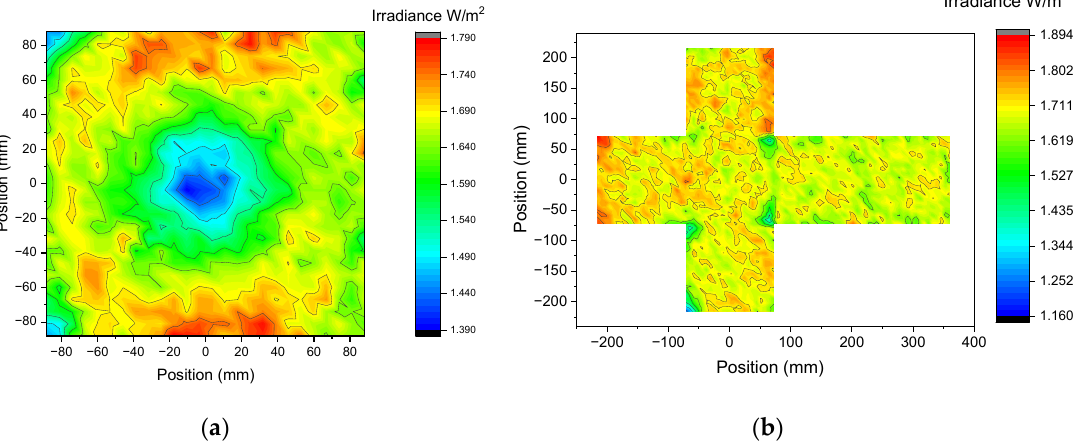
Figure 10. Simulated irradiance generated by the 56 LEDs prototype on a 176 × 176 cm 2 flat surface ( a ) and on a cube with a side of 144 mm (net of the cube on the ( b )), false color